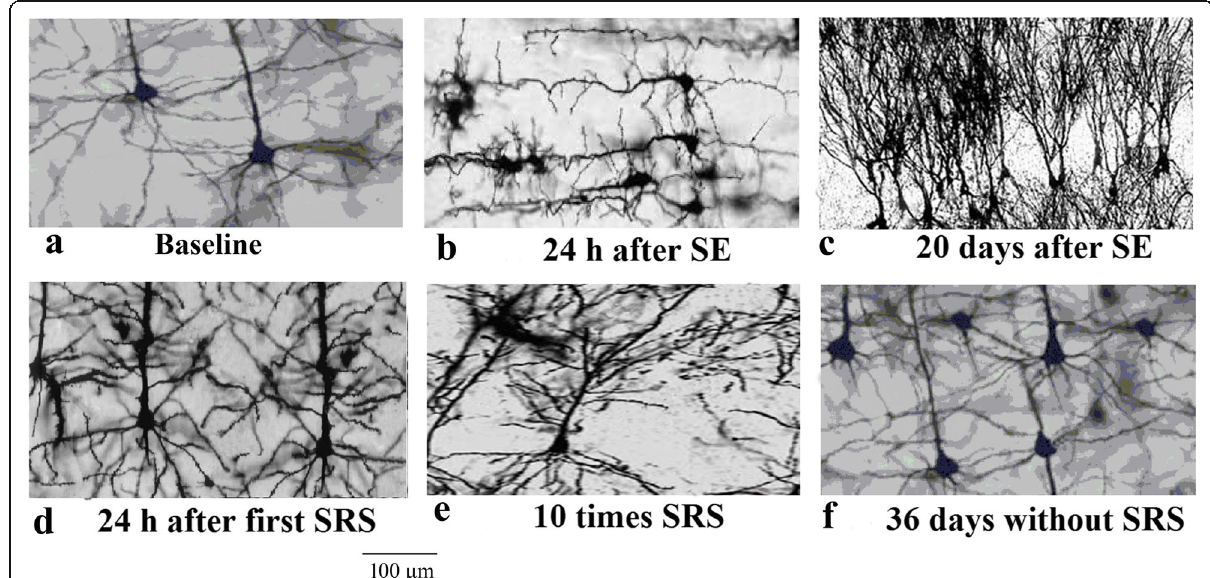
Fig. 4 Dendritic complexity and arborization patterns in the CA3 region. Spontaneous seizures decreased the number of neurons and dendritic complexity in epileptic rats ( d and e ), and the epileptic rats experiencing 10 times of SRS showed more degeneration of dendritic arbors than those undergoing only one SRS episode. In contrast, dendritogenesis increased during the latent phase ( b and c ). Scale bar represents 100 μ